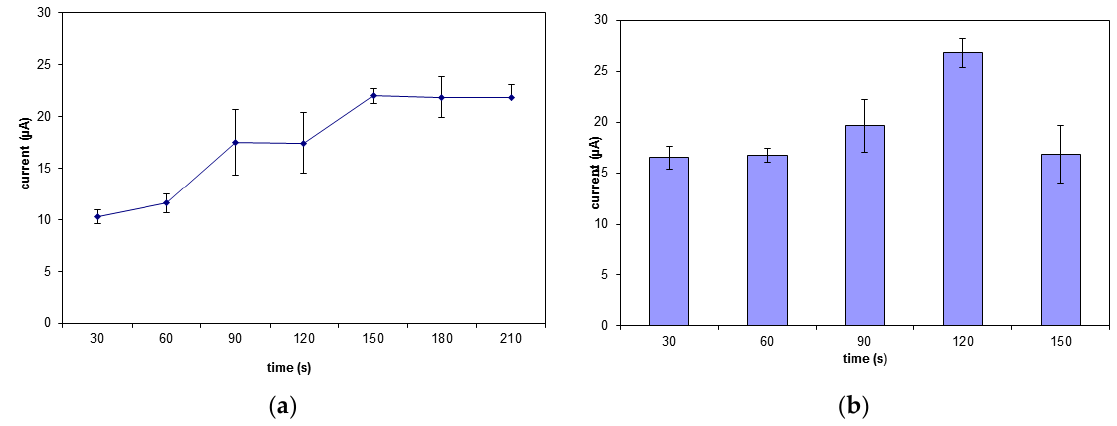
Figure 6. The interaction time of the ( a ) MB and ( b ) carcinogen with the biosensor.